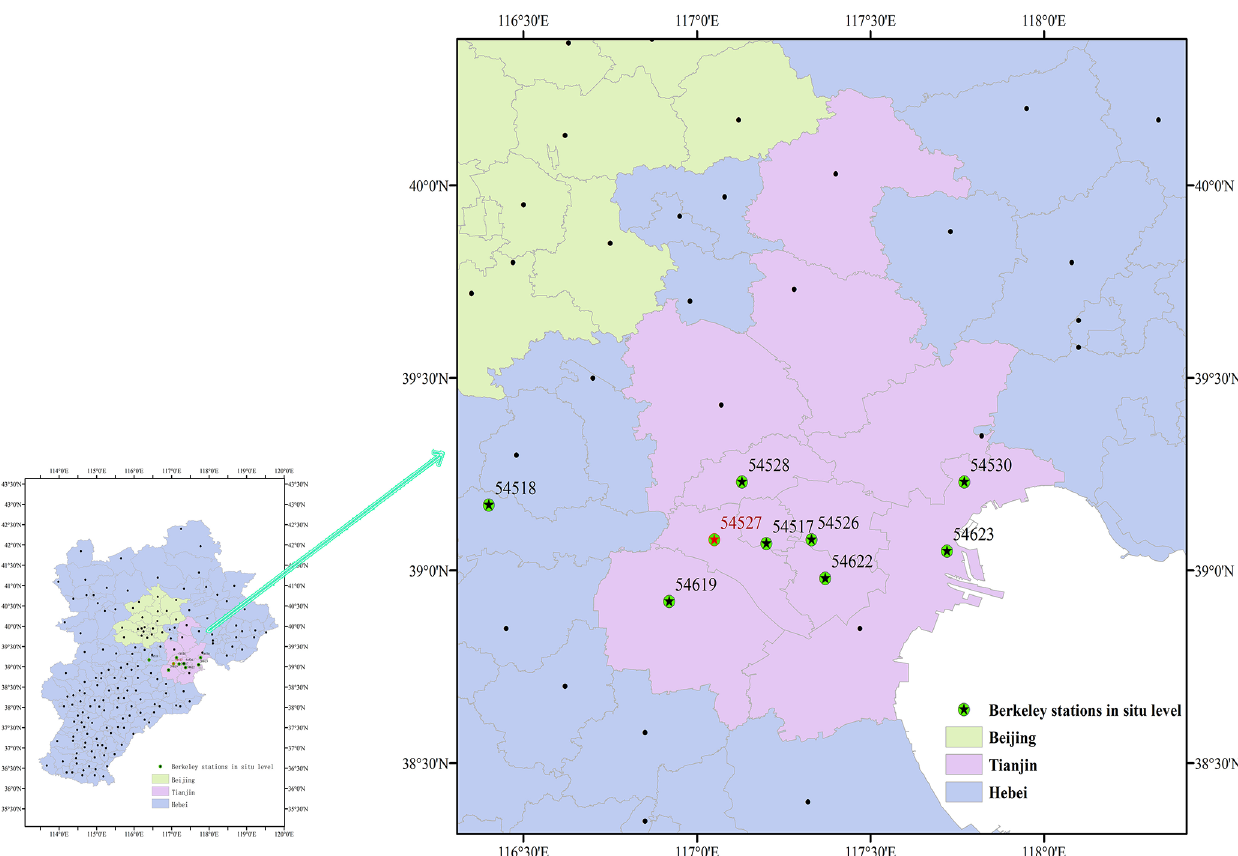
Figure 5. Geographical distribution of the surface weather stations (solid black circles) in the Beijing–Tianjin–Hebei area in China and the nine selected stations (solid green circles with black or red